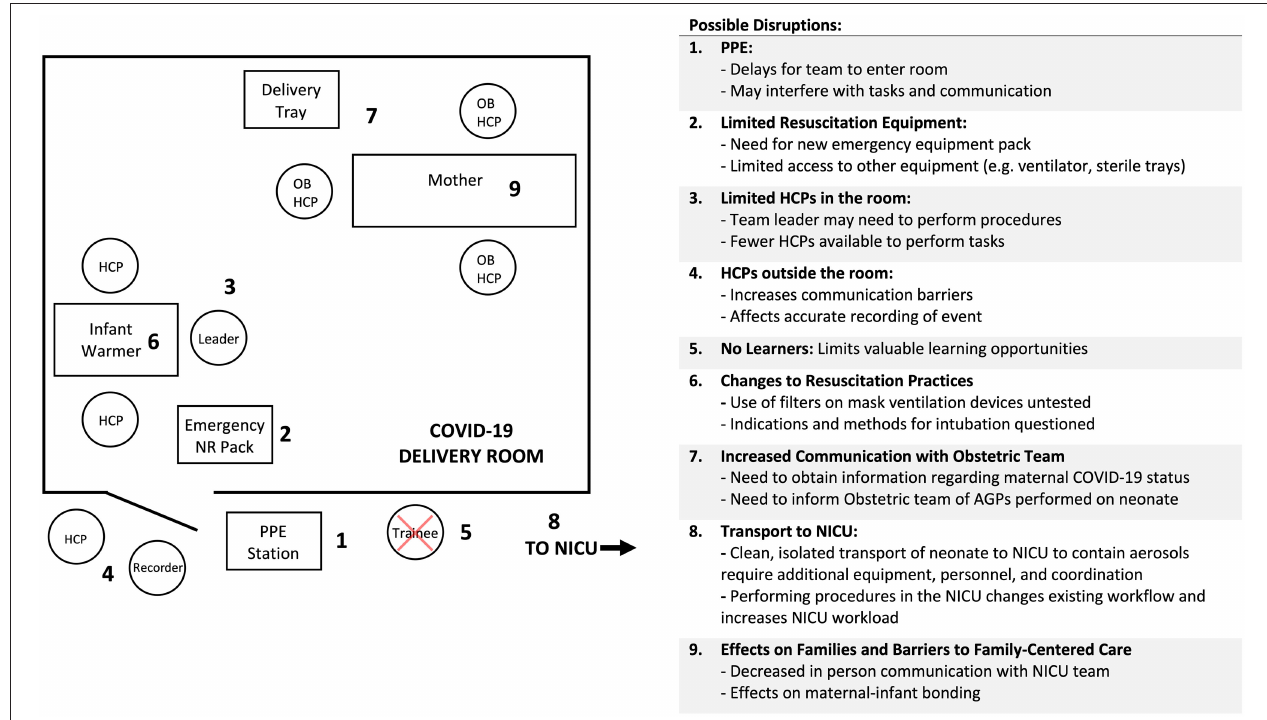
FIGURE 1 | High risk COVID-19 delivery room layout and changes to neonatal resuscitation workflow (HCP, Healthcare Provider; OB, Obstetrics; PPE, Personal Protective Equipment; NR, Neonatal Resuscitation; NICU, Neonatal Intensive Care Unit).